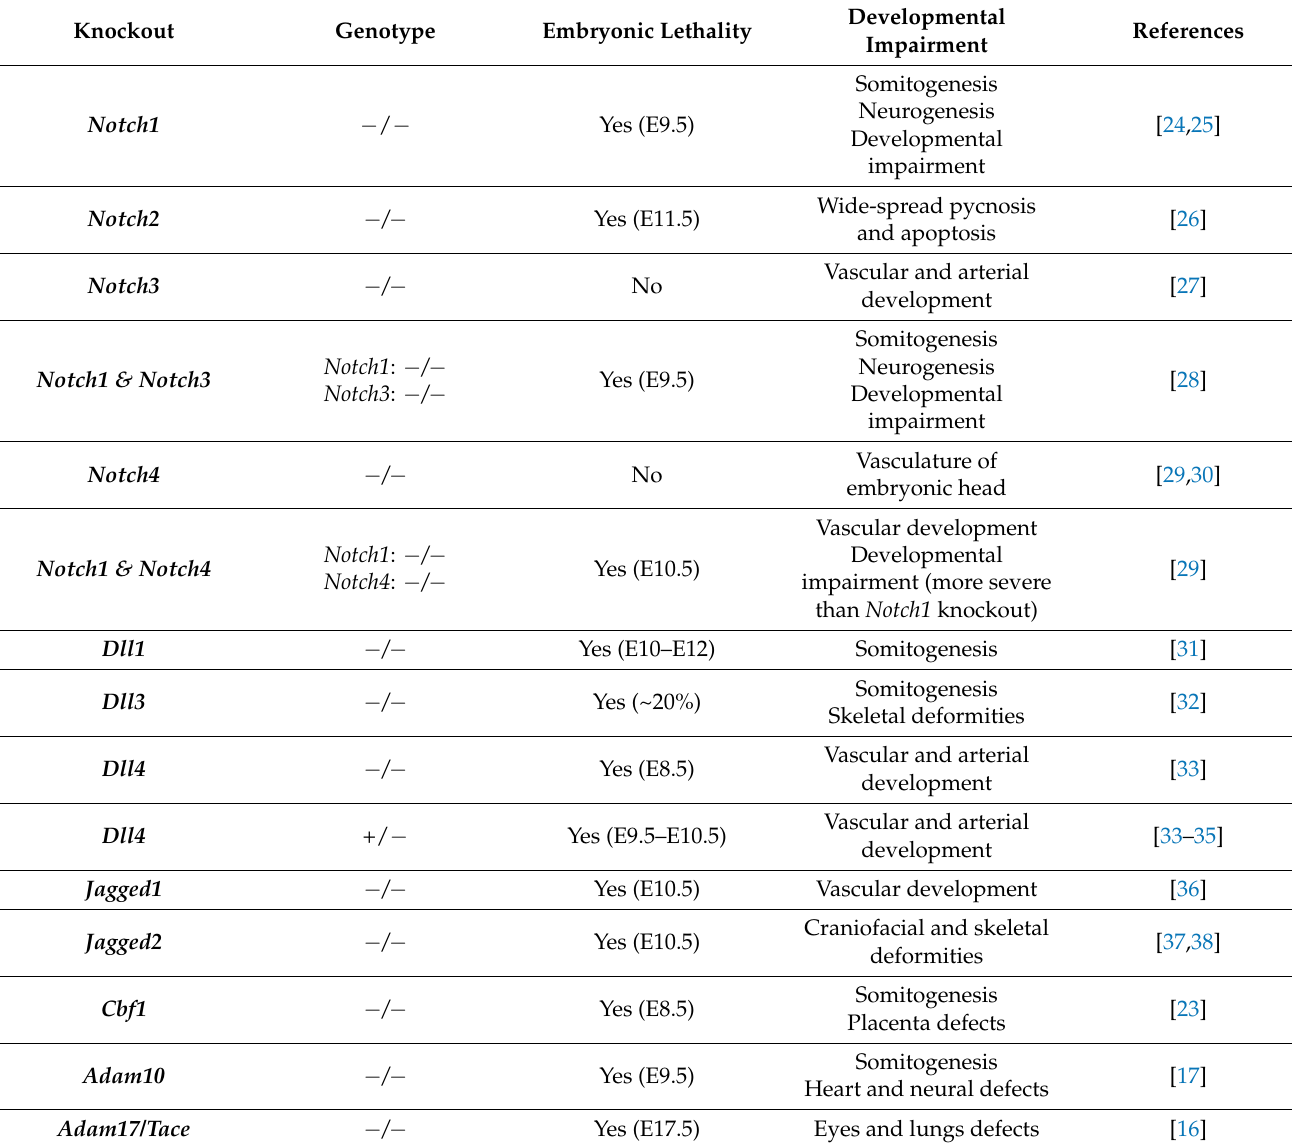
Table 1. Knockout mouse models of the Notch signaling